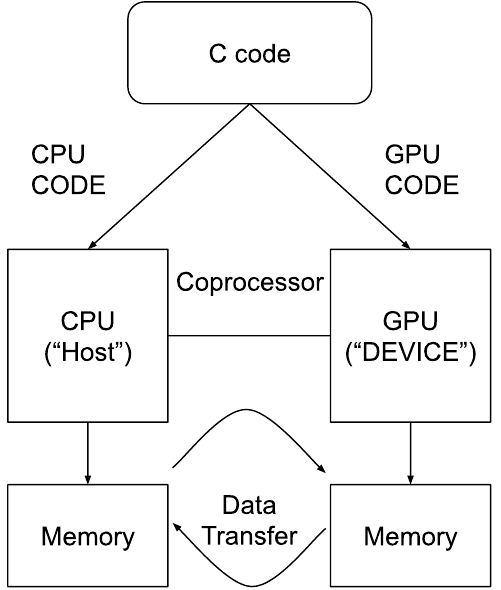
Figure 2. Count of LU operations vs matrix